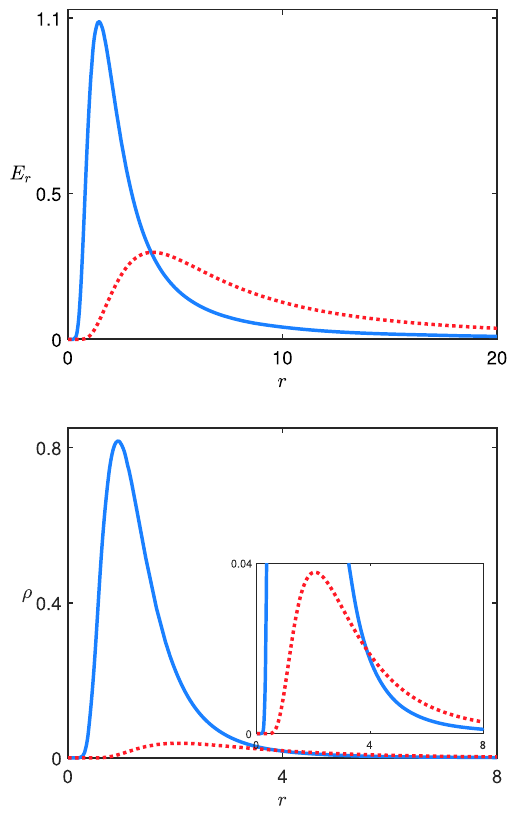
Fig. 5 The radial component of the electric field (top) with e = 1 and the energy density (bottom) associated to the model in Sect. 3.2 for σ = 5, with k = 1 (solid, blue line) and 2 (dotted, red line). The inset in the bottom figure shows the interval ρ ∈ [ 0 , 0 . 04 ]